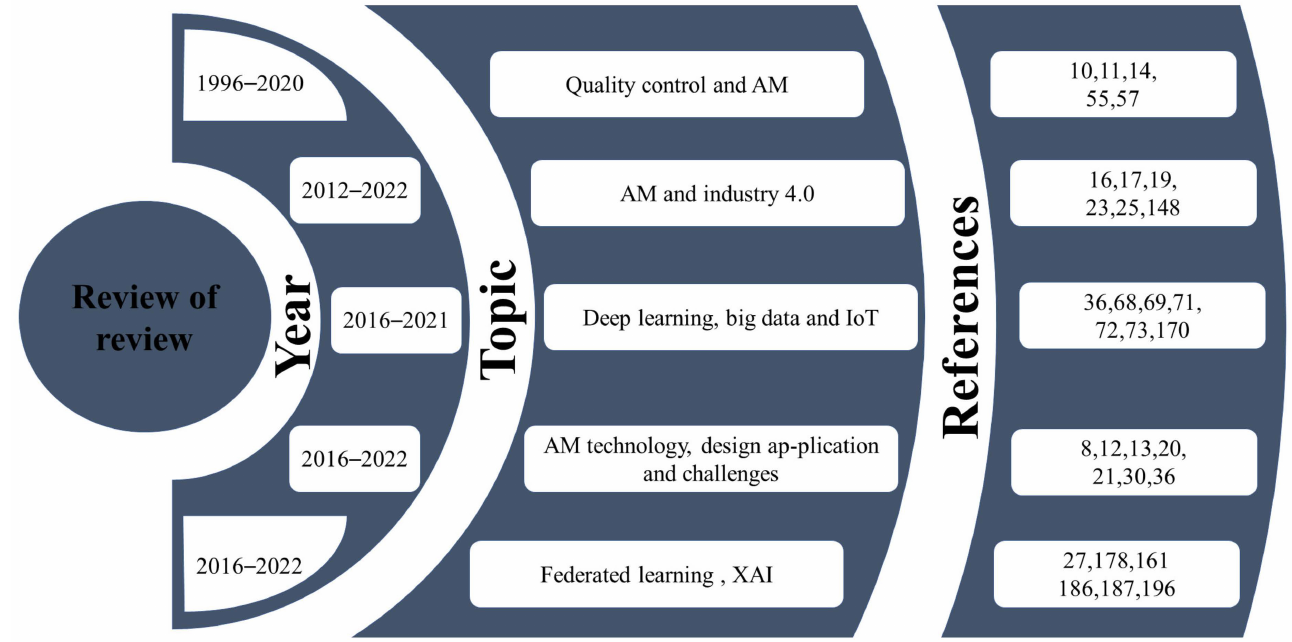
Figure 1. Various review of the review for deep learning towards digital additive